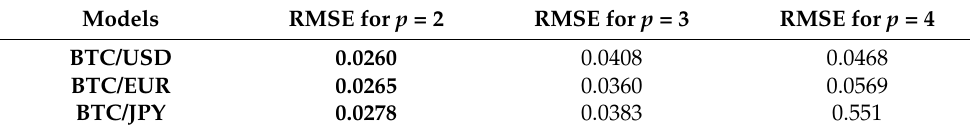
Table 10. Minimum RMSE for datasets using CMCMA model with different expansion order.